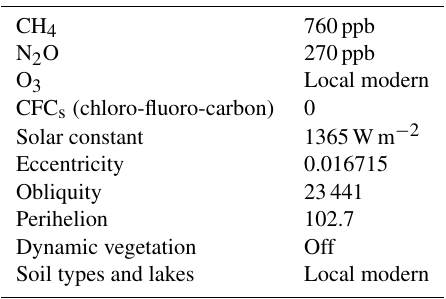
Table 1. Configuration common to all experiments described in this